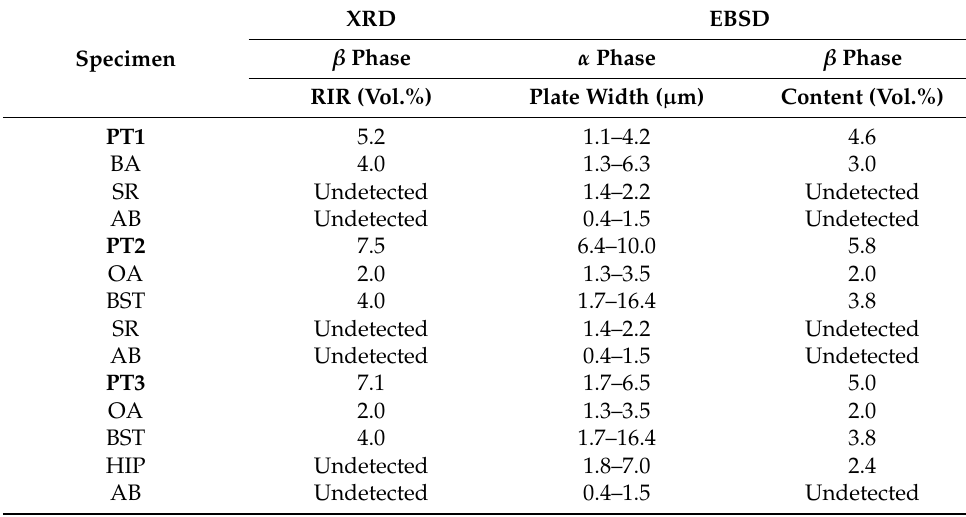
Table 1. XRD results of β -phase content compared to the EBSD results of the α plate lamellae width, the β -phase content for: PT1, PT2, and PT3.